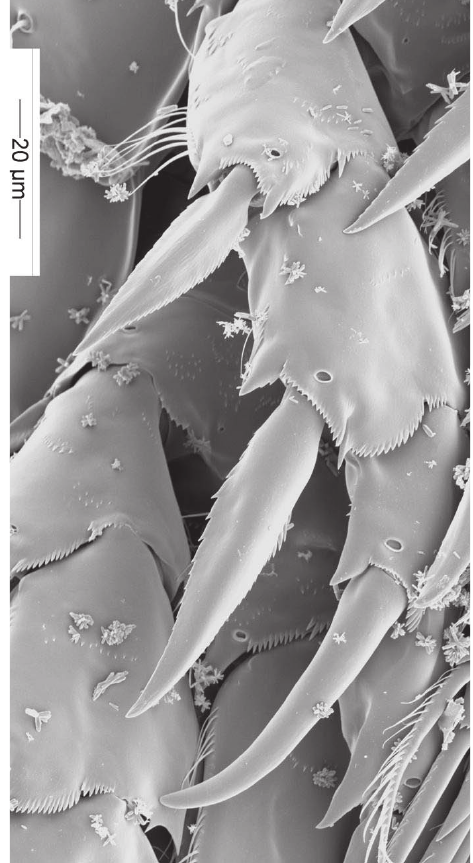
Fig . 4. – scanning electron micrograph of right exopod of leg 2 of male P. xiphophorus from lake faro, antero-lateral view show- ing weak modifications of proximal spine on outer margin of third exopodal